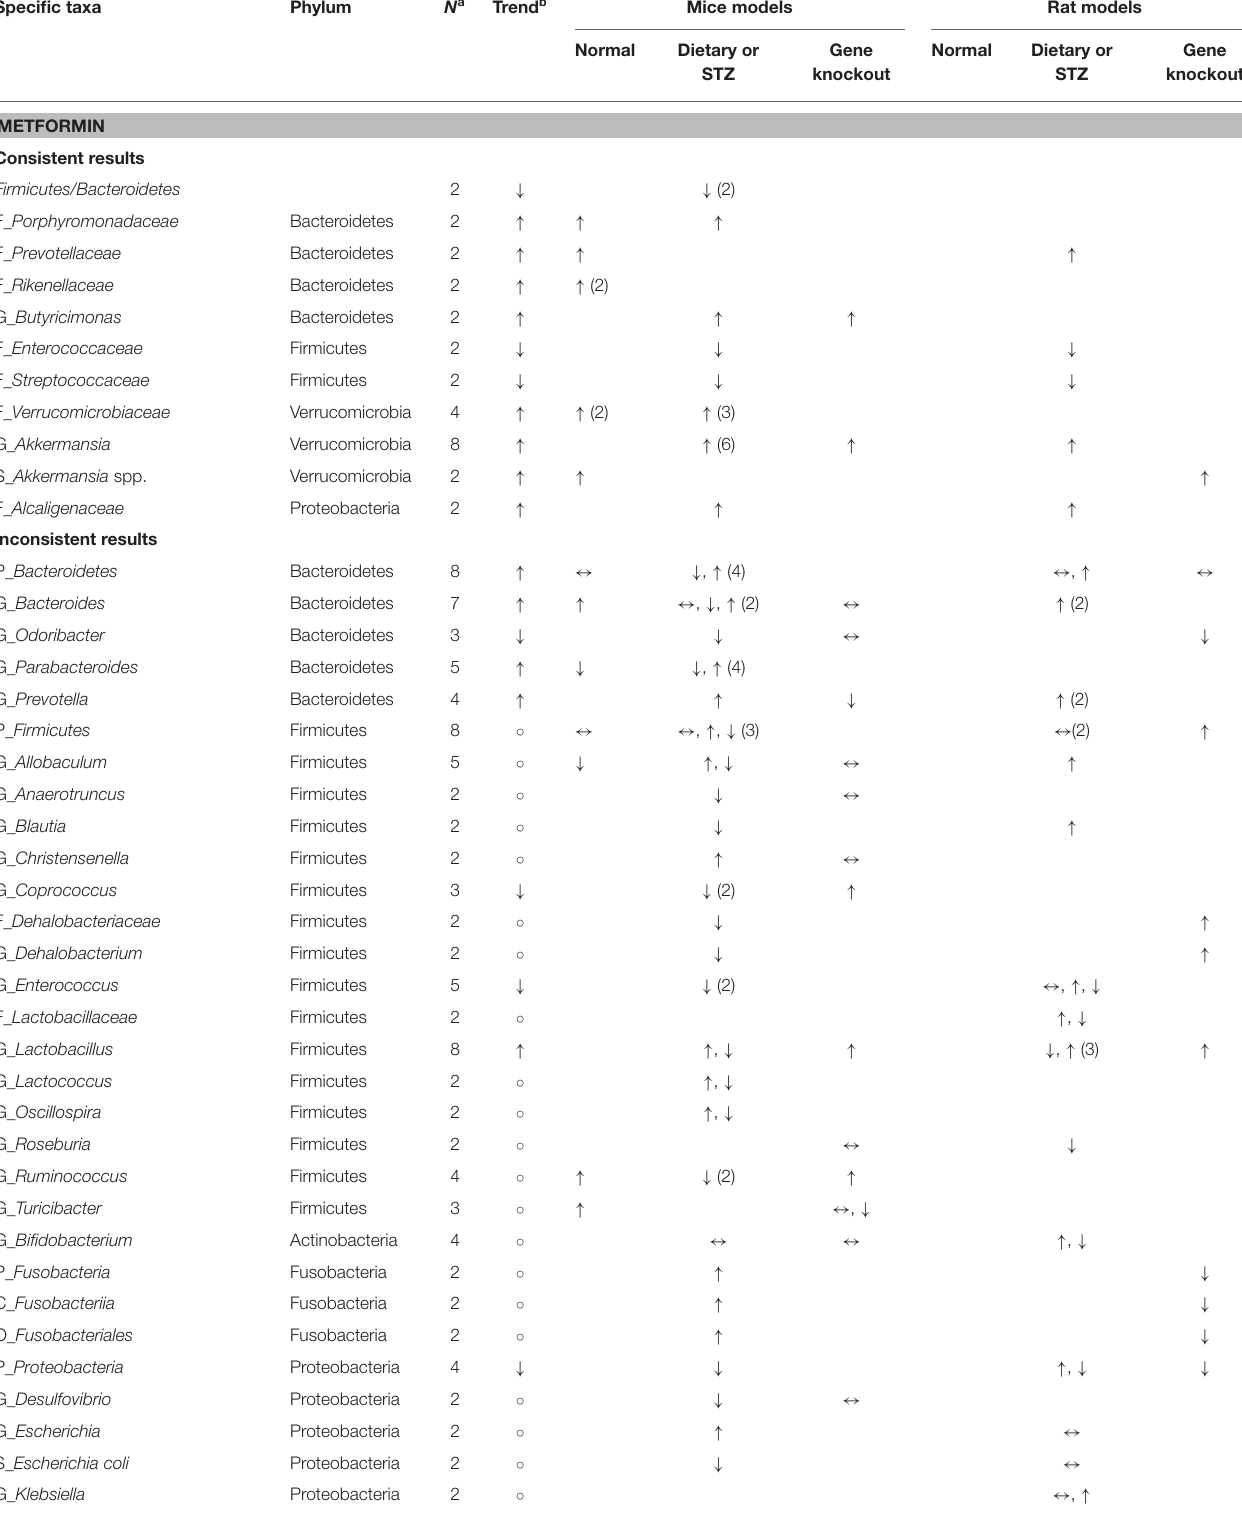
TABLE 7 | Consistent and inconsistent effects of each anti-hyperglycemic drug on specific taxa in mouse gut microbiota, categorized by mice or rat models with three distinct animal models. Specific